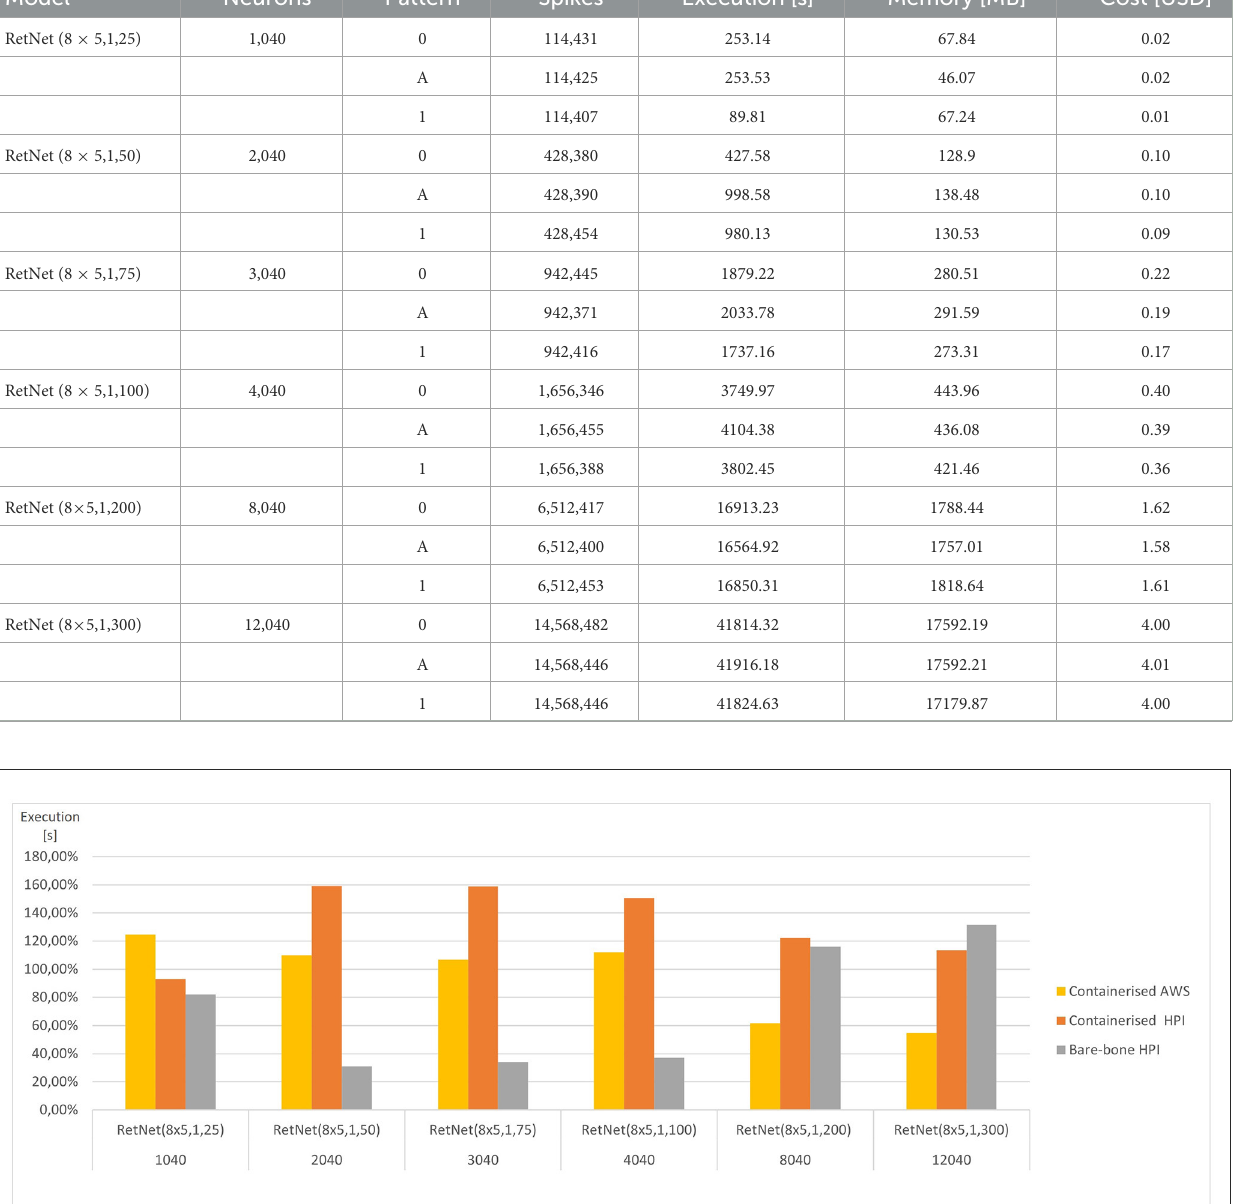
TABLE 3 Neural Simulation Pipeline—containerized execution on AWS cloud computing infrastructure. Containerized AWS Model Neurons Pattern Spikes Execution [s] Memory [MB]